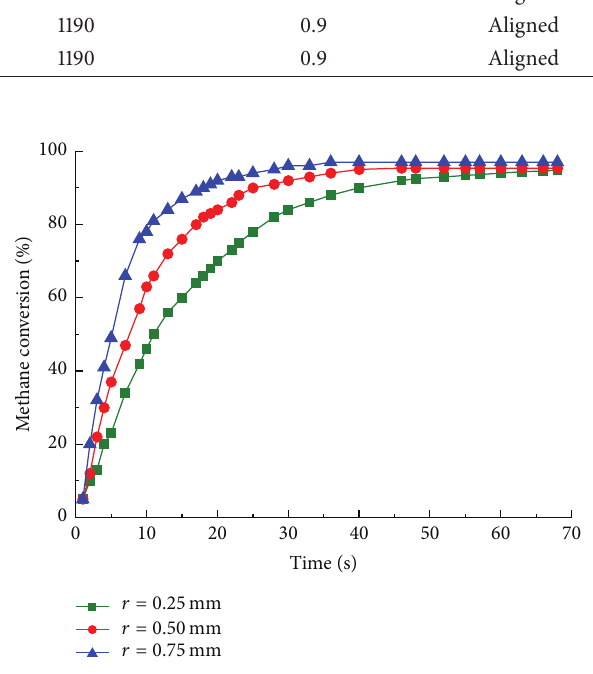
Figure 3: Mass fraction of methane along sectional position with cylinder radius of 0.25 mm ( ◼ ), 0.50 mm ( e ), and 0.75 mm ( 󳵳 ) at reaction time of 3 s.